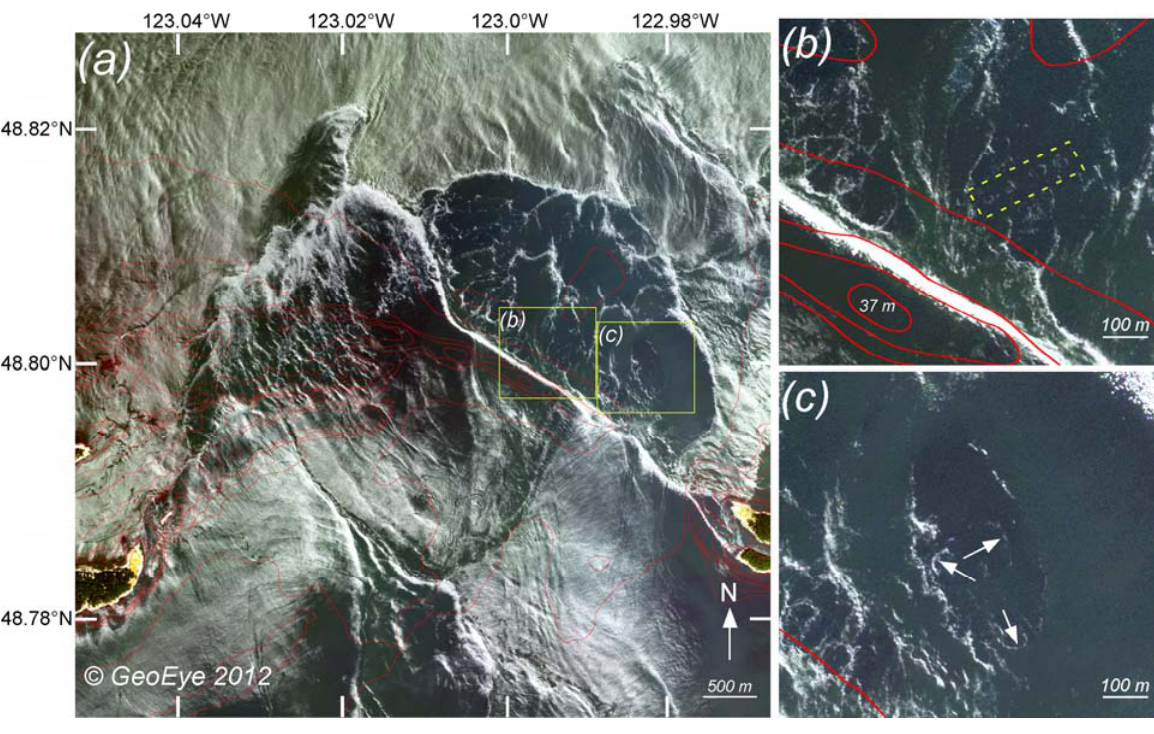
Figure 4. GeoEye-1 multispectral imagery from 1934 UTC 14 July 2012. ( a ) Same spatial extent as in the previous figure. Red curves are isobaths; ( b ) Enlarged view of sill crest, showing wave-current interaction zone (white band) and a series of small boils (dashed yellow box); ( c ) Large oval-shaped area with interior boil signatures